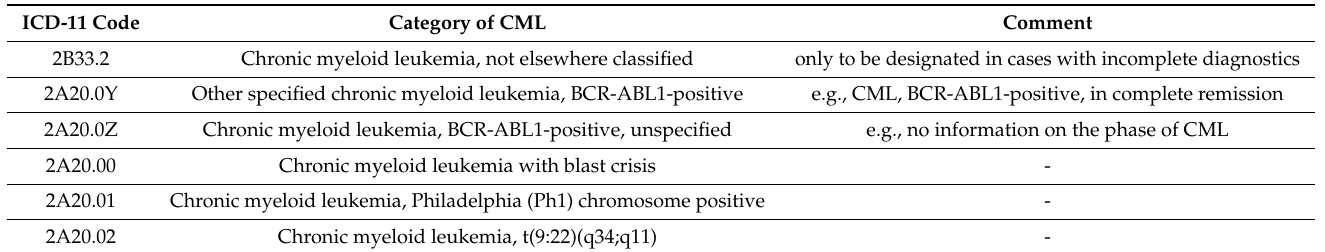
Table 2. Categorization of CML by the current codes of the International Classification of Diseases